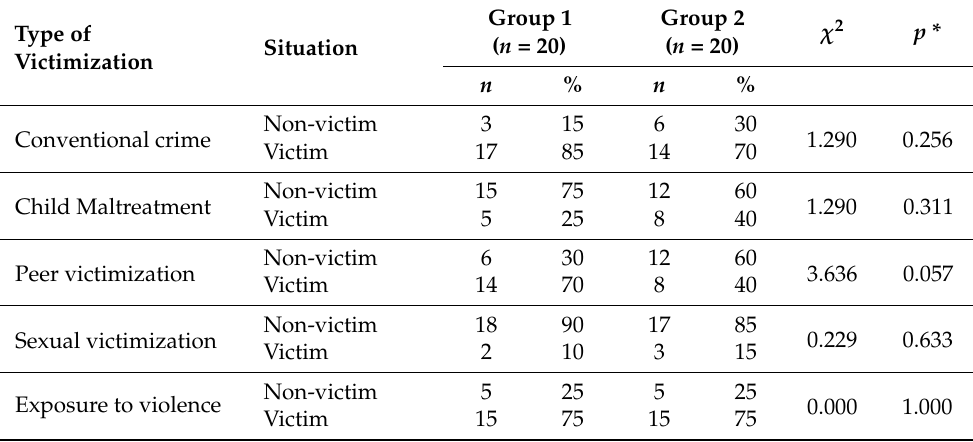
Table 3. Characterization by crime typologies in the